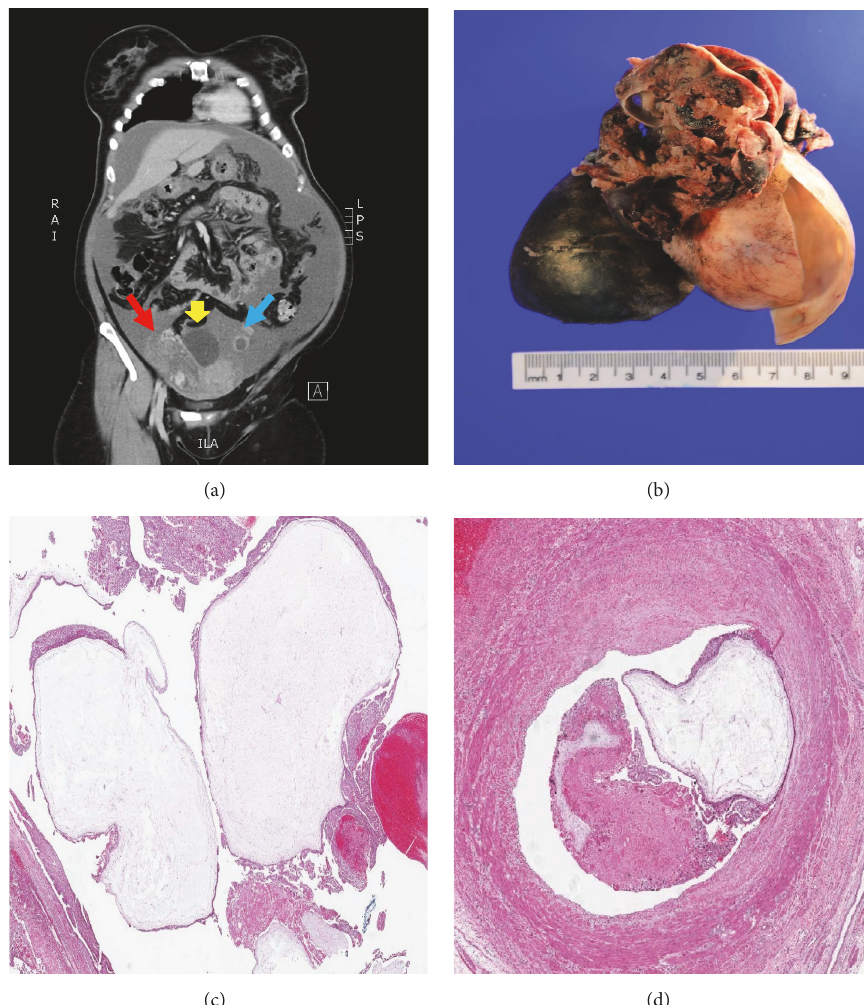
Figure 1: (a) CT scan without contrast revealed large right complex adnexal mass (red arrow), with the attached cyst (yellow arrow) and the left ovary (blue arrow). The blue arrow shows the left ovary. (b) Gross photo shows ruptured fallopian tube with placental-like tissue and adjacent cyst. (c) Hematoxylin and eosin (H&E) histopathology examination demonstrates dilated villi with cistern and circumferential trophoblastic proliferation (H&E; 1x). (d) Vascular invasion (H&E;